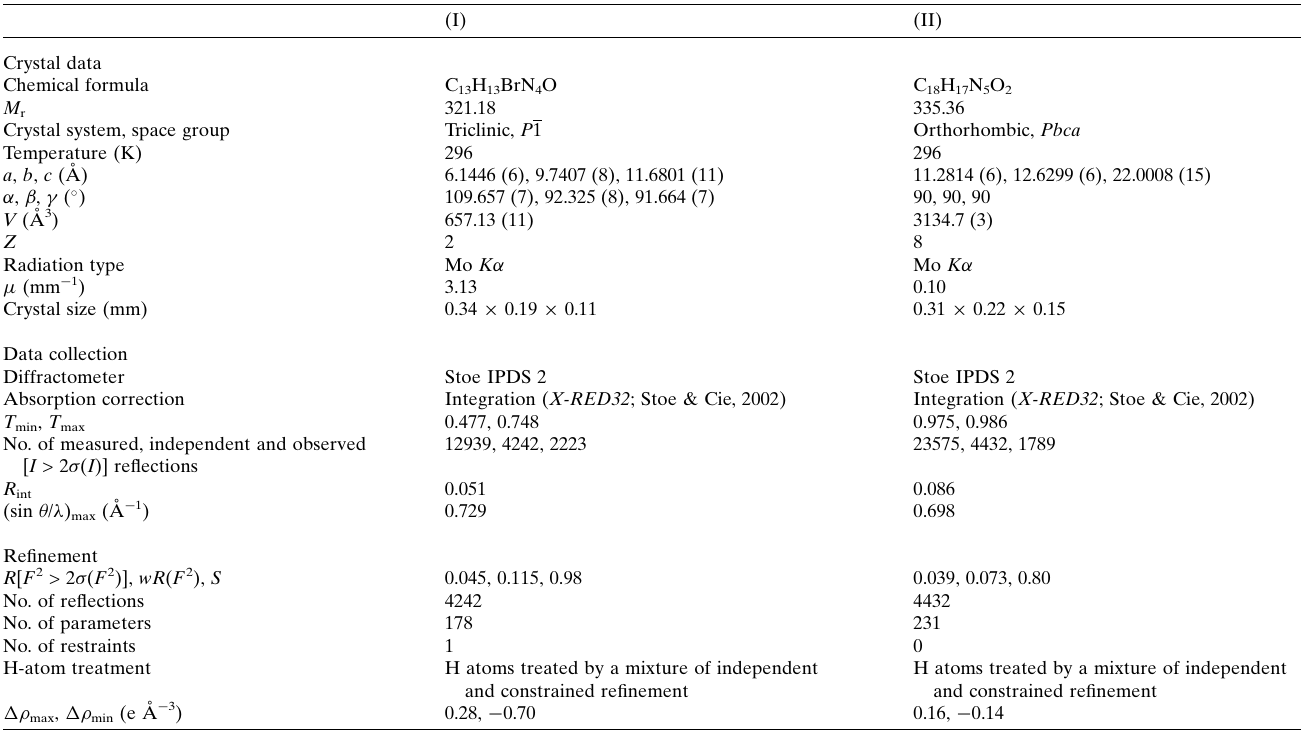
Table 3 Experimental details.